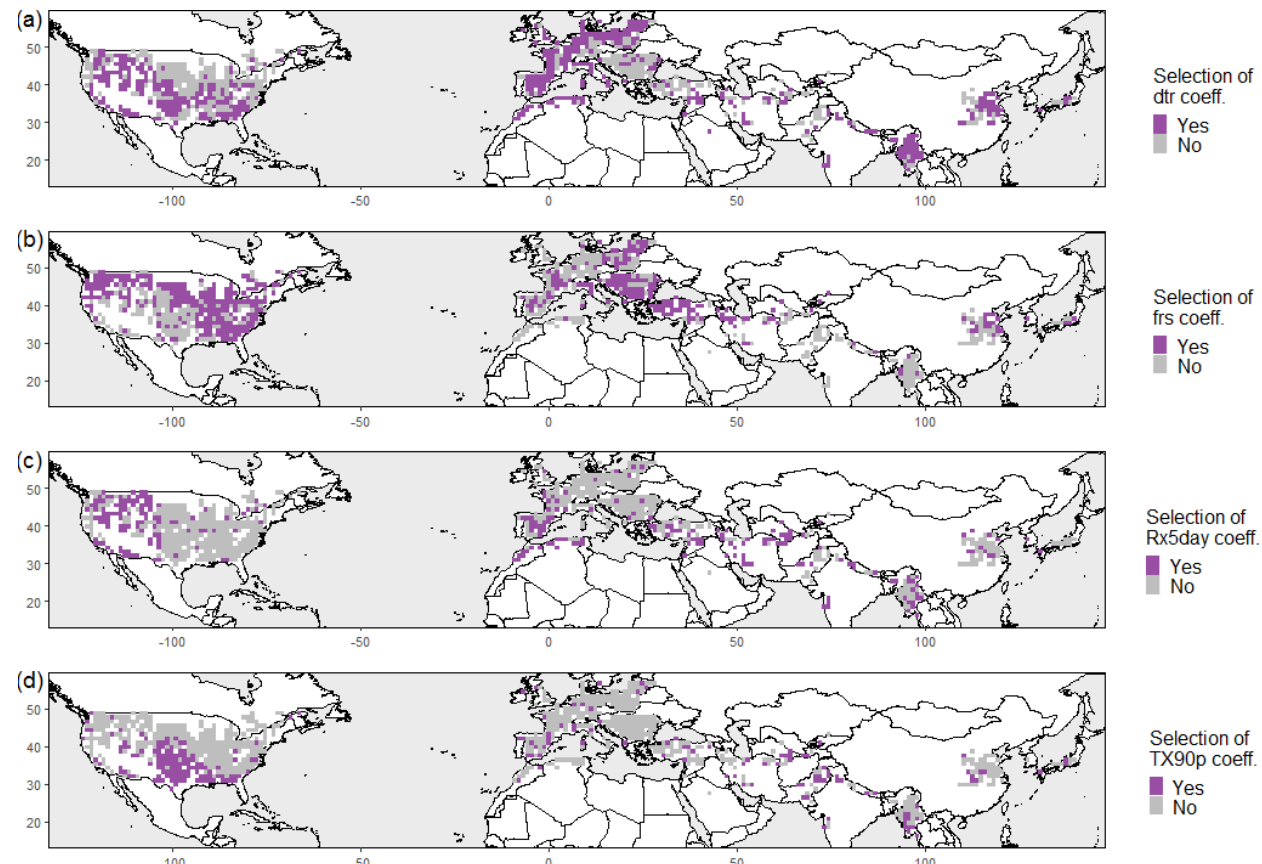
Figure B5. Selected climate extreme indicators (Table 1) in the LASSO logistic regression model for each location: dtr (a) , frs (b) , Rx5day (c) and TX90p (d)